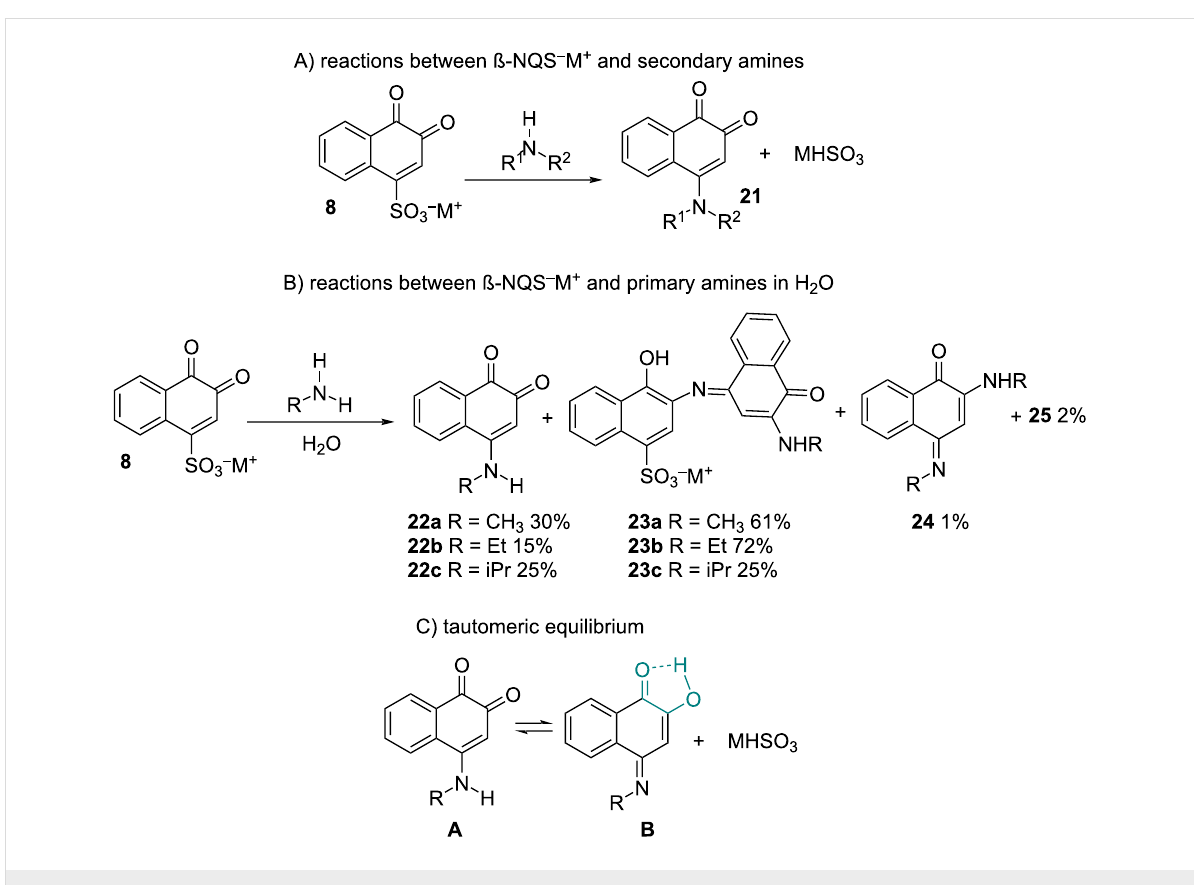
Scheme 3: Reactions between β -NQS and